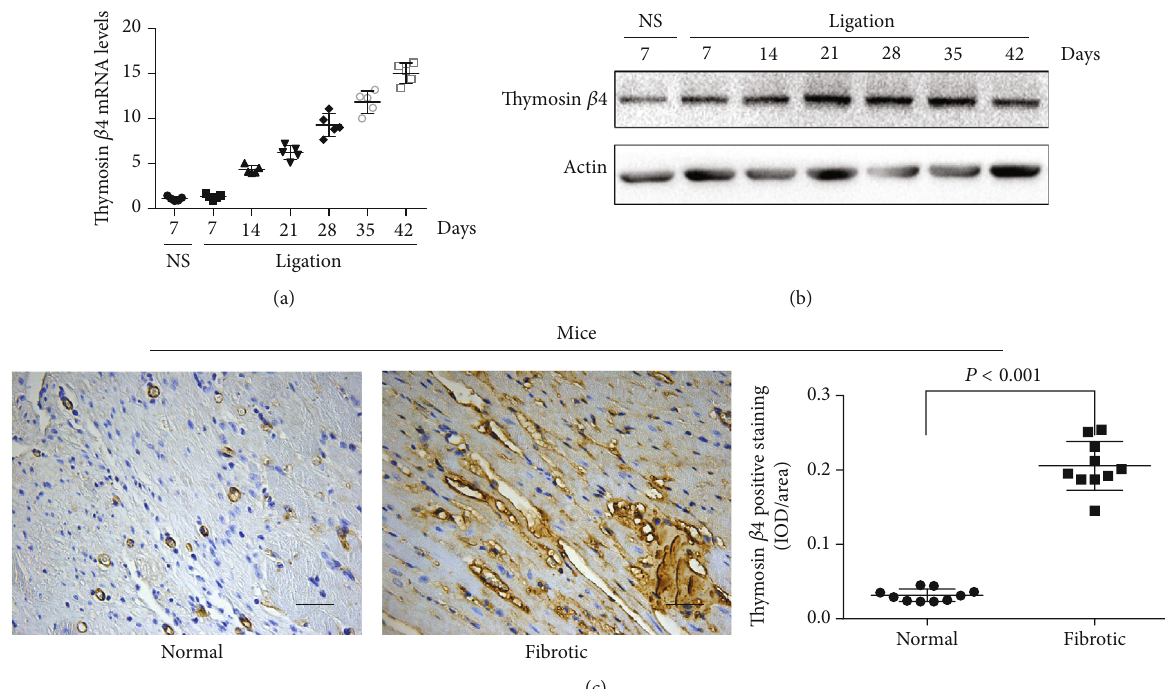
Figure 2: Expression of T β 4 in infracted mouse heart tissues. The expression of T β 4 in mouse heart tissues at both mRNA (a) and protein (b) levels. Immunohistochemistry of T β 4 in normal and infracted mouse heart tissue (c). Scare bars = 100 μ m.